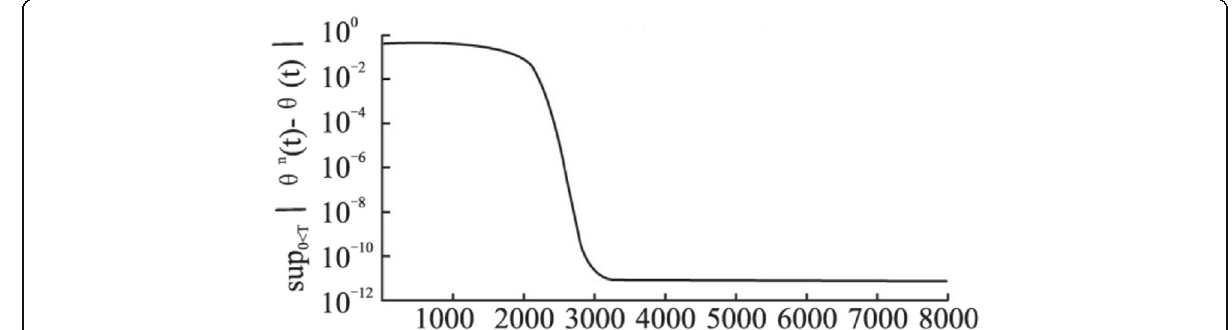
Fig. 9 Iterative output